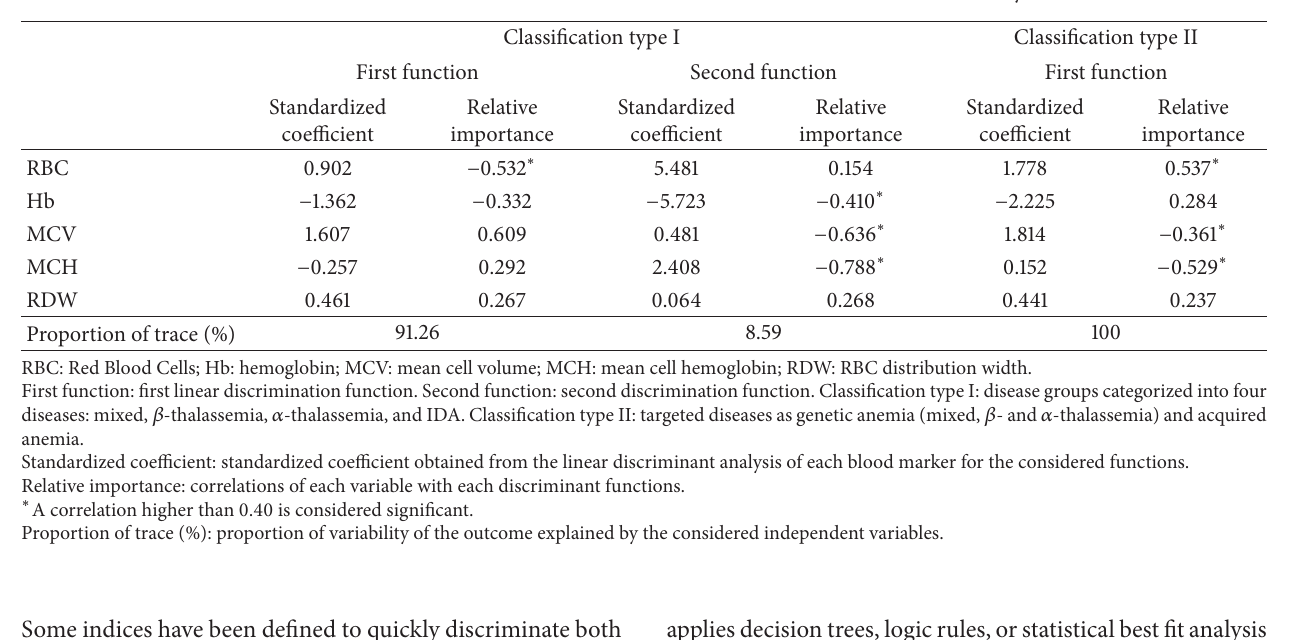
Table 2: Standardized canonical coefficients obtained from the linear discriminant